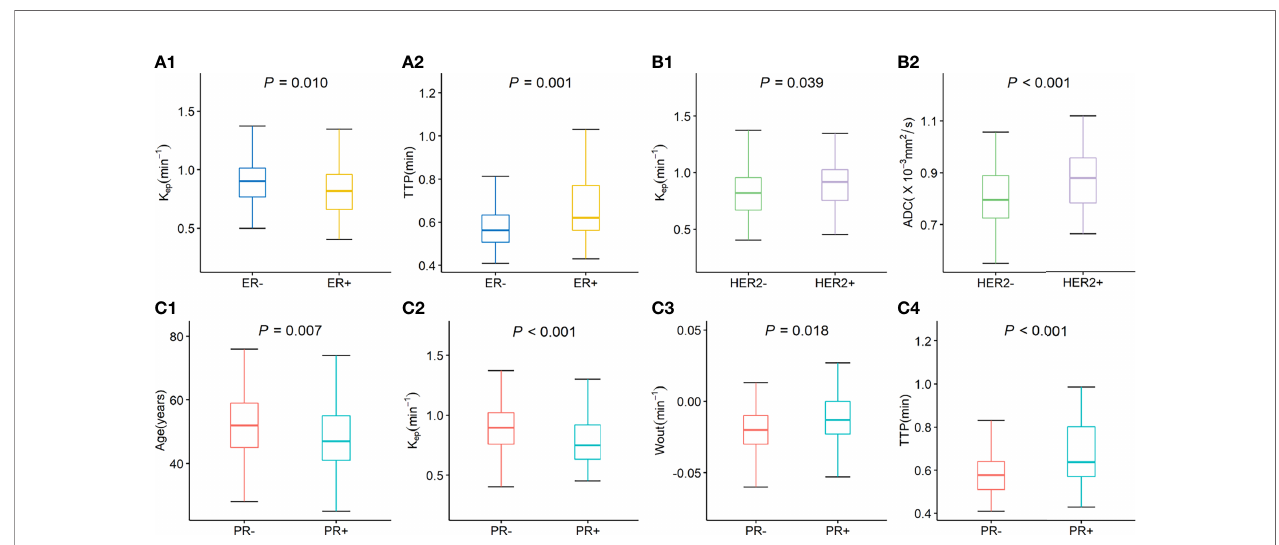
FIGURE 2 | Box plot graphs revealing statistically signi fi cant differences in values for different receptor statuses. The K ep and TTP values were signi fi cantly difference in ER status (A1, A2) . The K ep and ADC values were signi fi cantly difference in HER-2 status (B1, B2) ; The age, K ep W-out, and TTP values were signi fi cantly difference in PR status (C1 – C4)